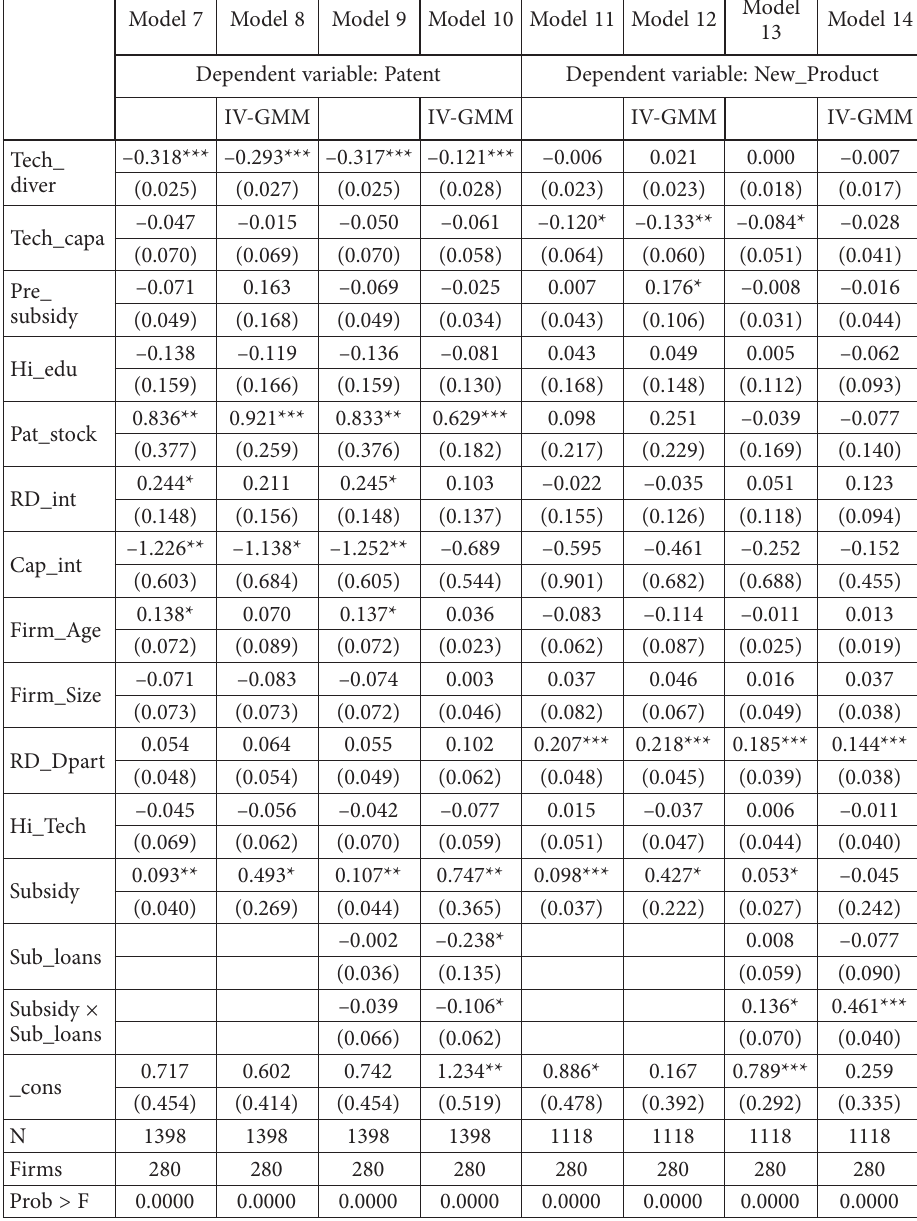
Table 4. The robustness check by adopting standard panel data models with fixed